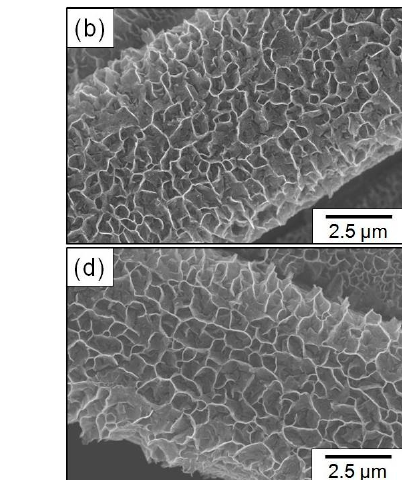
Figure 3. Cyclic voltammogram responses for the 20th, 500th, and 1000th scans of first test of 1000 cycles using ( a ) the Pt-CNW electrode and ( b ) the CNW electrode without Pt nanoparticles in PBS solution with 240 μ M of H 2 O 2 , together with a CV curve for the first scan without H 2 O 2 . ( c ) Variation of peak current value at the potential of –0.1 of CV curves recorded from 1 to 3000 cycles.